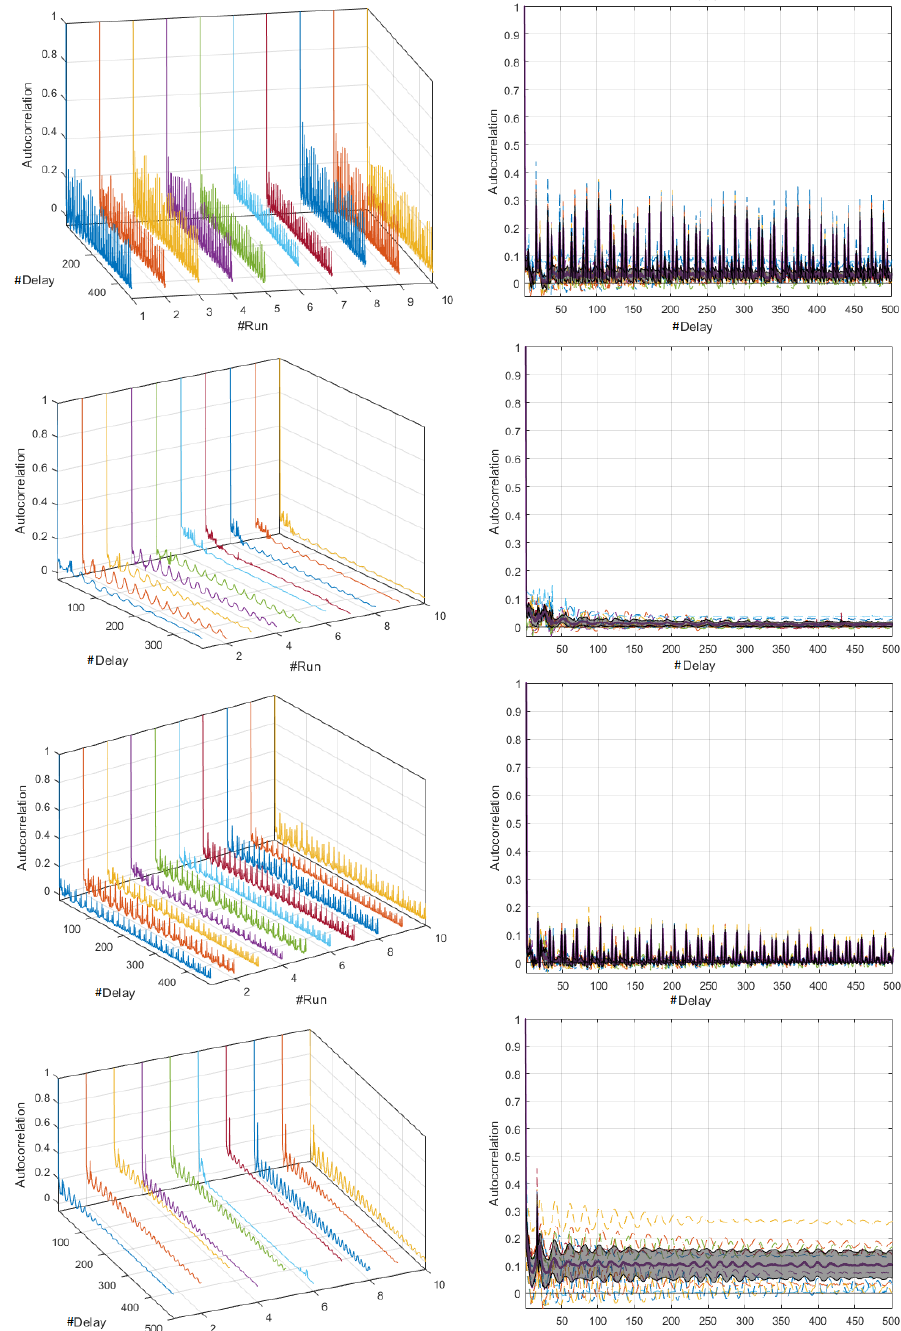
Figure A6. Plots of SAF for DigiMesh network at 9600 bauds: ( Left ) M-mode; and ( Right ) autocorrelograms of each realization, and the bootstrap CI. From top to bottom: Coordinator and Nodes